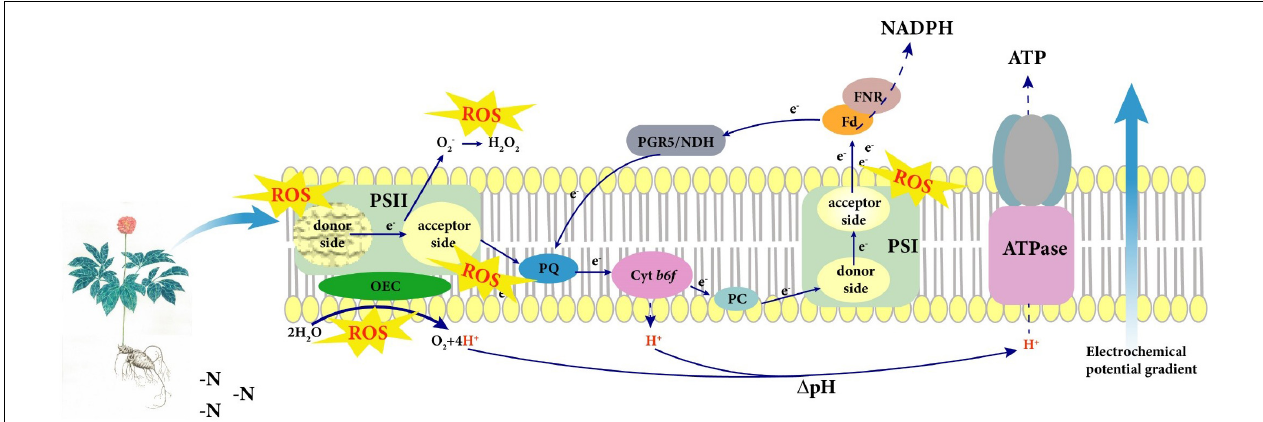
FIGURE 10 | A model was proposed for the adaptation strategy of photosystem in the nitrogen (N)-sensitive plants represented by Panax notoginseng under low N (LN) condition. The lower linear electron flow (LEF) leads to the hindrance of the formation of (cid:49) pH and ATP under LN, thereby damaging the donor side of the PSII oxygen-evolving complex (OEC). However, the activation of cyclic electron flow (CEF) slows down the damage rate of PSII under LN. Additionally, the over-reduction of PSI acceptor side is the main cause of PSI photoinhibition in N-sensitive species P. notoginseng under LN, and higher CEF and antioxidant enzyme activity protects PSI from photodamage. Craquelure represents the damage of